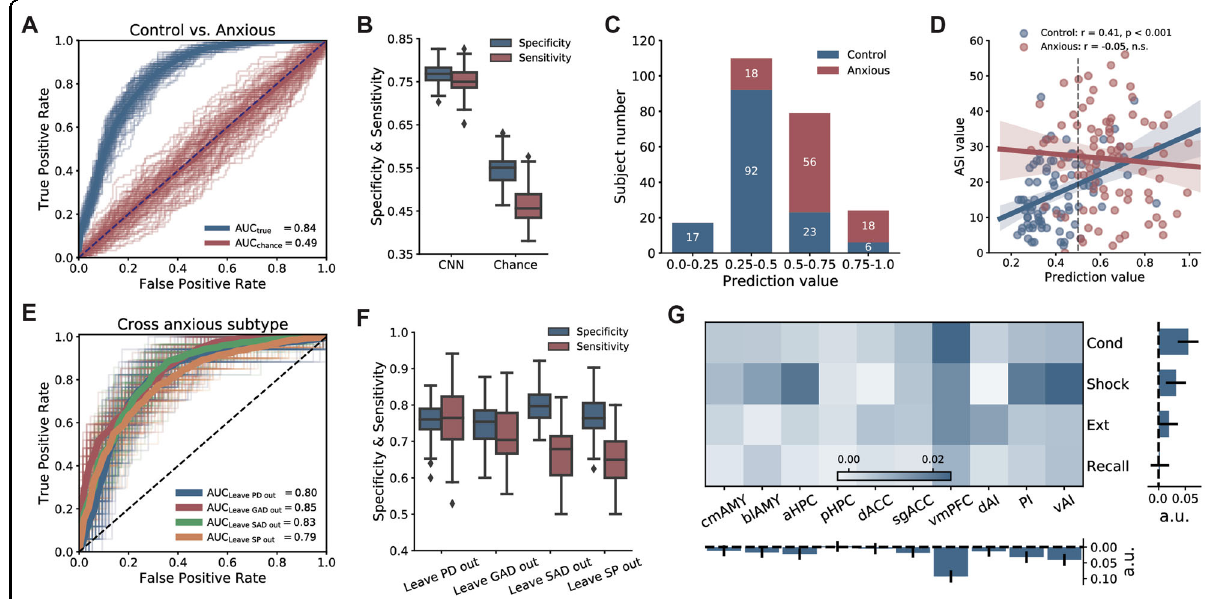
Fig. 2 Performance for discriminating anxious brains with various types of anxiety disorder. A ROC curves obtained using 5-fold cross- validation. As a comparison, the ROC curves derived from shuf fl ed data and the chance-level AUC are shown. B Box plots of speci fi city and sensitivity. The whiskers extend to the most extreme data points not considered outliers, and the outliers are labeled as ‘ ♦ ‘ . C Empirical distribution of prediction scores. D The prediction score positively correlated with the anxiety sensitivity index (ASI) for the control group ( r = 0.41, p = 7.4e-5), but at the chance level for anxious brains ( r = − 0.05, p = 0.65). E Generalization of cross-subtypes in anxiety disorders (e.g., PD, GAD, SAD, or SP) was assessed by classi fi cation analysis. F Box plots of speci fi city and sensitivity in cross-subtype classi fi cation. G The relative importance of 40 brain activation features assessed by their contributions. A greater positive coef fi cient (a.u.) implied more